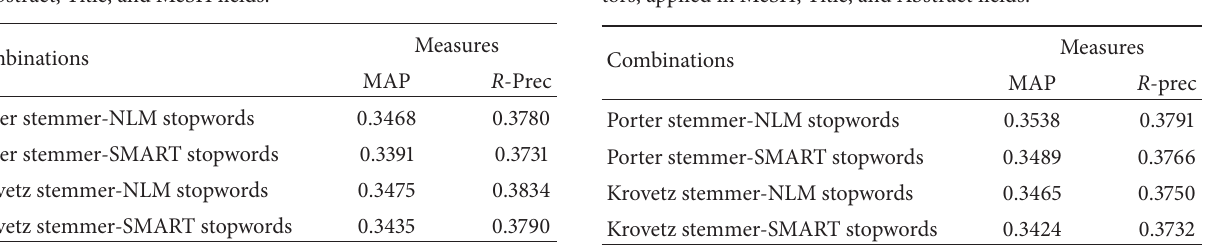
Table 9: Evaluation measures using the pseudorelevance feedback Table 10: Evaluation measures using query expansion with